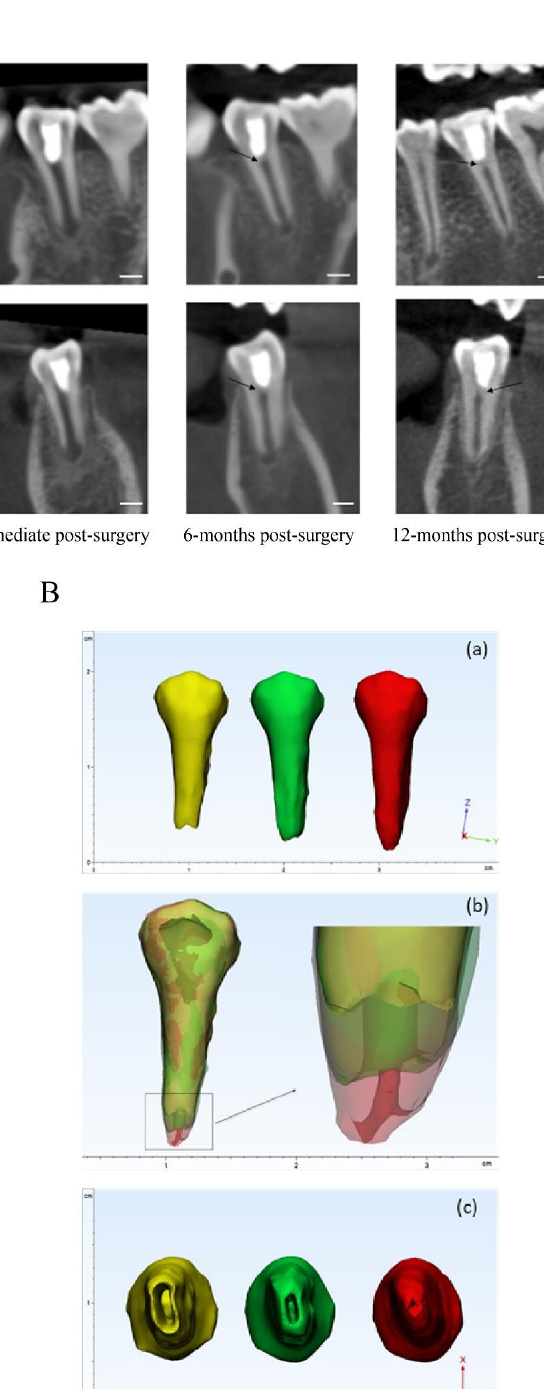
Figure 3. Representative images of an MTA treated tooth; ( A ): radiographic image in the sagittal and coronal views of the tooth immediately post-surgery, 6-months post-surgery, and 12-months post-surgery. Dentin bridge (black arrow) and continued root formation were observed at 6- and 12-months follow-up in a time-dependent manner. ( B) : ( a ) 3D reconstructed tooth immediately post-surgery (yellow), 6-months post-surgery (green), and 12-months post-surgery (red). Increased root development post-treatment was observed; ( b ) the superimposed 3D tooth immediately, 6-months, and 12-months post-surgery. The enlarged image demonstrates the root apex position and root canal shape of the tooth; ( c ) the apical view of the tooth at the 3 time points. The narrowing of the apical foramen is demonstrated in a time-dependent manner. Scale bar = 3